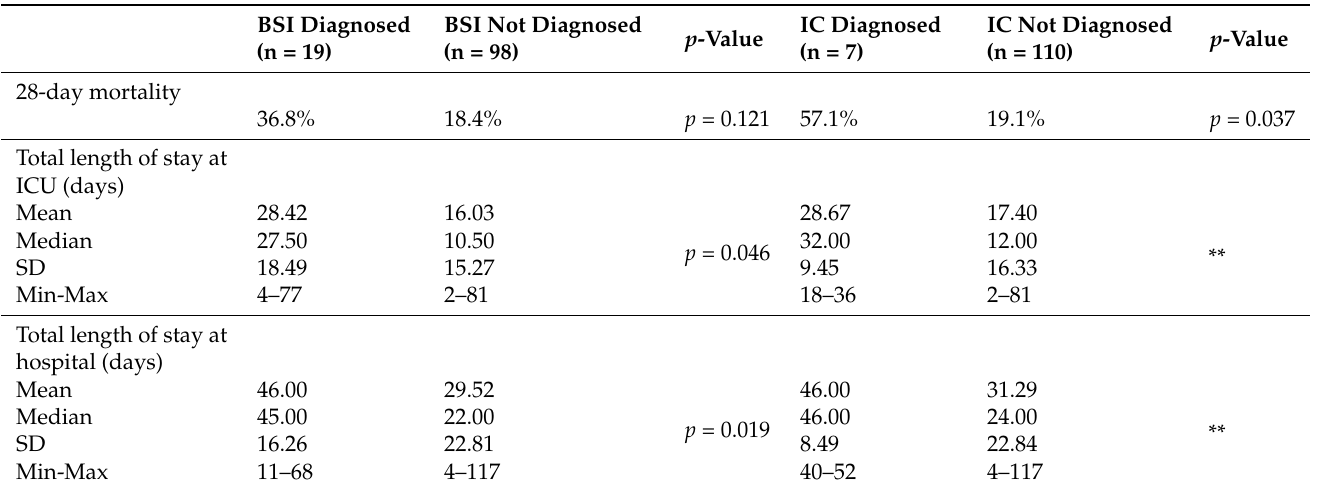
Table 5. Influence of presence of BSI (blood-stream infection) or IC (invasive candidiasis) in 28-day mortality or length of stay at ICU (intensive care unit) and hospital. ** no p -value available due to low number of cases.